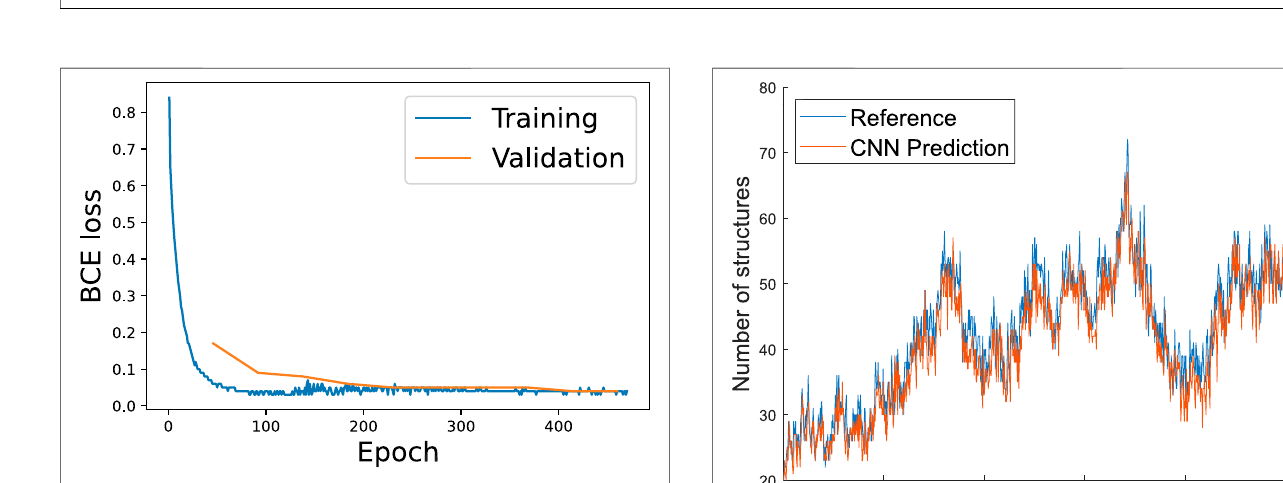
FIGURE 5 | Schematic representation of the CNN-LSTM architecture employed in this study.